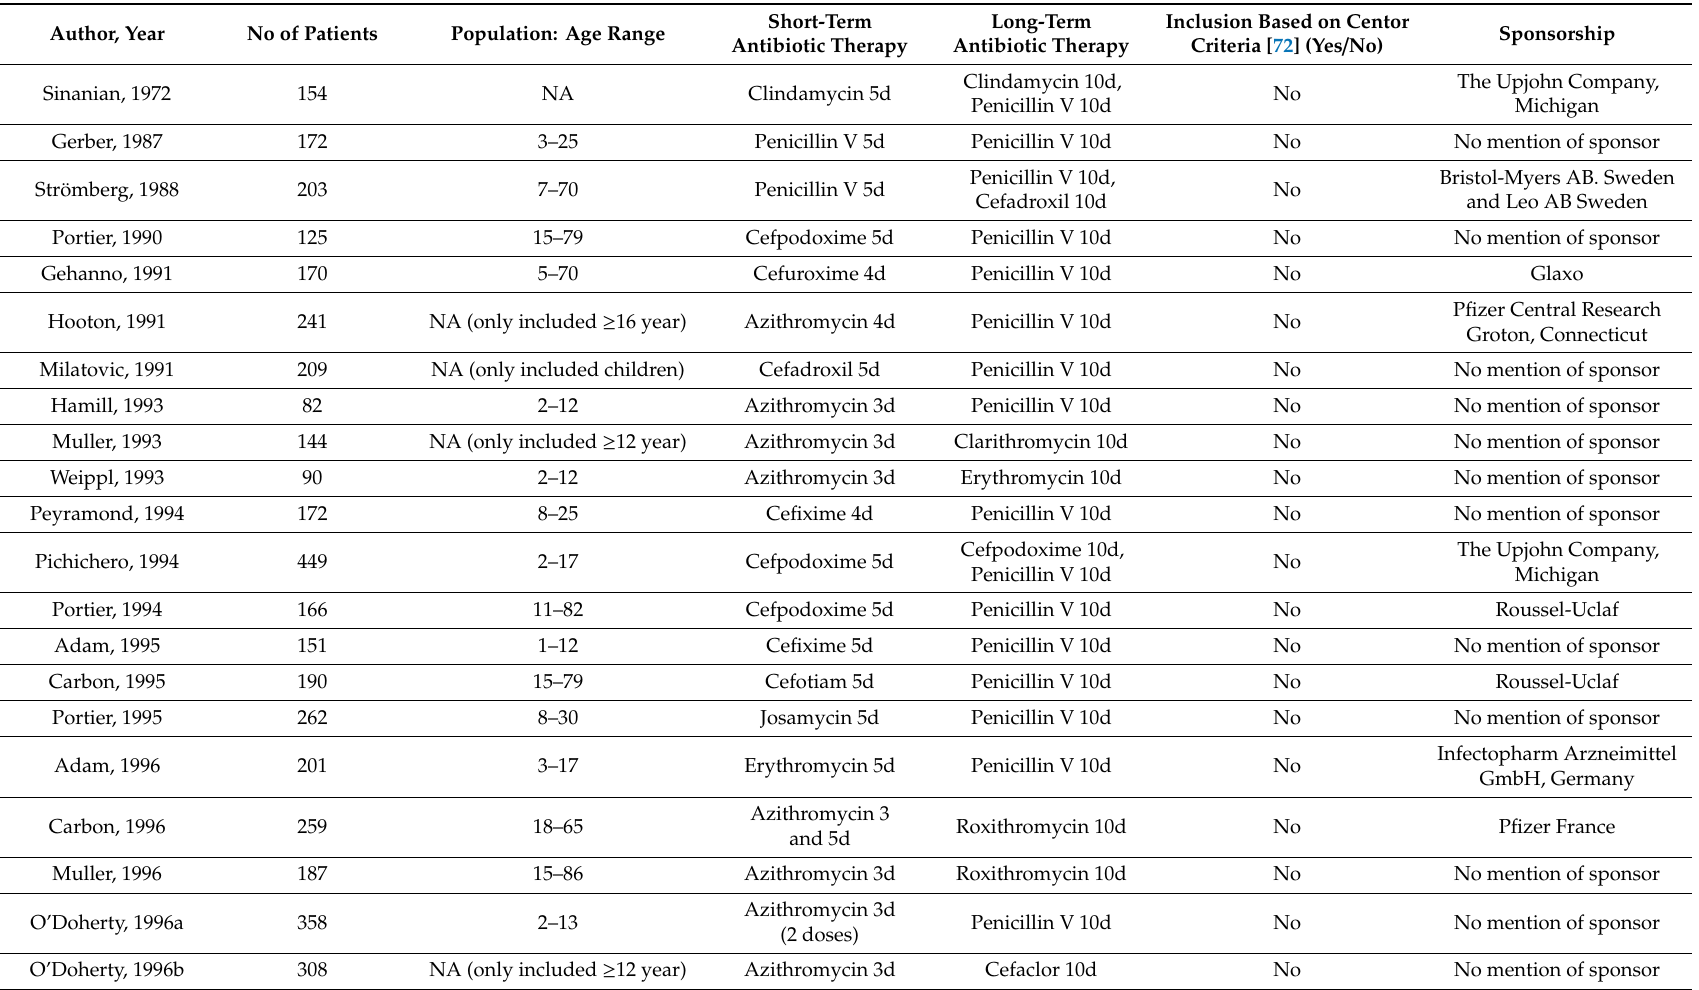
Table 1. Characteristics of the 50 trials included in the